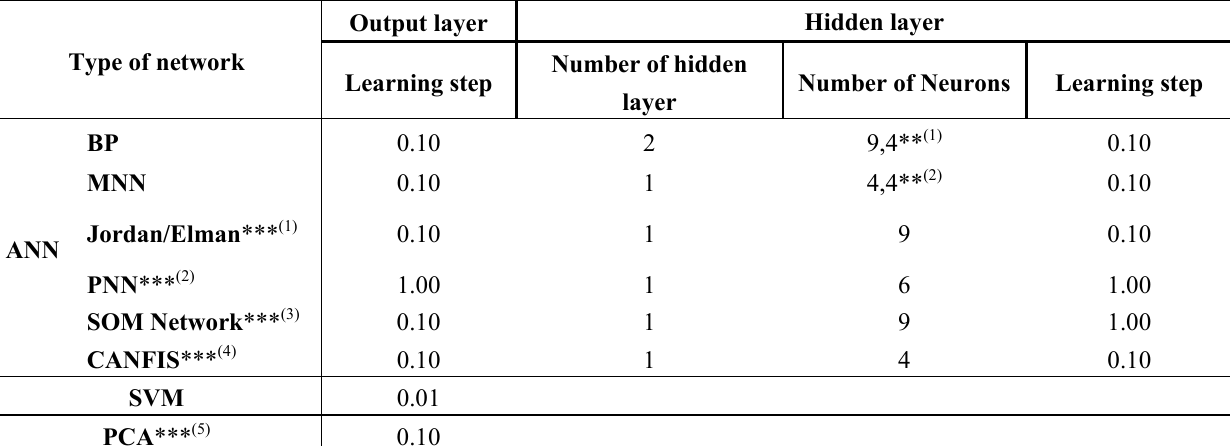
Table 4. Parameters of eight cloud classifiers *